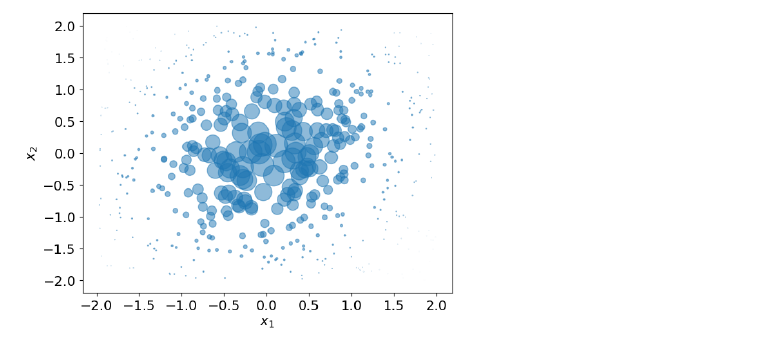
Figure 3. Set of 500 weighted samples (clue circles) estimating a 2D zero mean Gaussian distribution. The radius of a sample is proportional to its